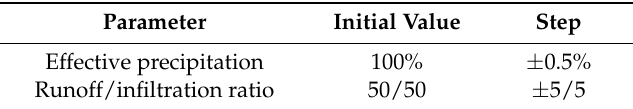
Figure 8. Comparison of the simulated and observed BOD values during dry and wet seasons for two different locations, namely, Kp Kelapa and PA Mangarrai (year 2004). (Dry: dry season; Wet: wet season; Obs: observed value; Sim: simulated value, Kp: Kp Kelapa; PA: PA Mangarrai). Table 3. Summary of parameters and steps used for calibration.